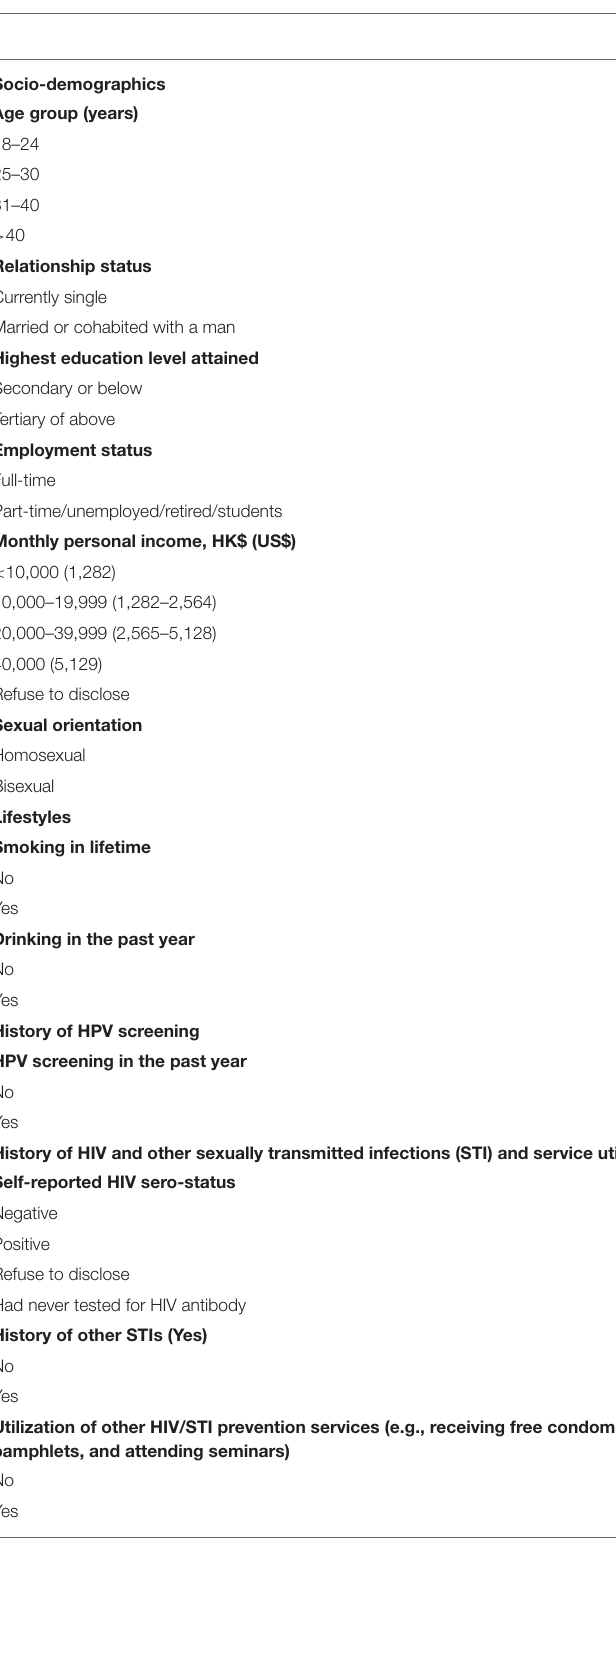
TABLE 2 | Baseline background characteristics predicting uptake of any HPV screening (among participants who completed Month 12 follow-up, n = 274).